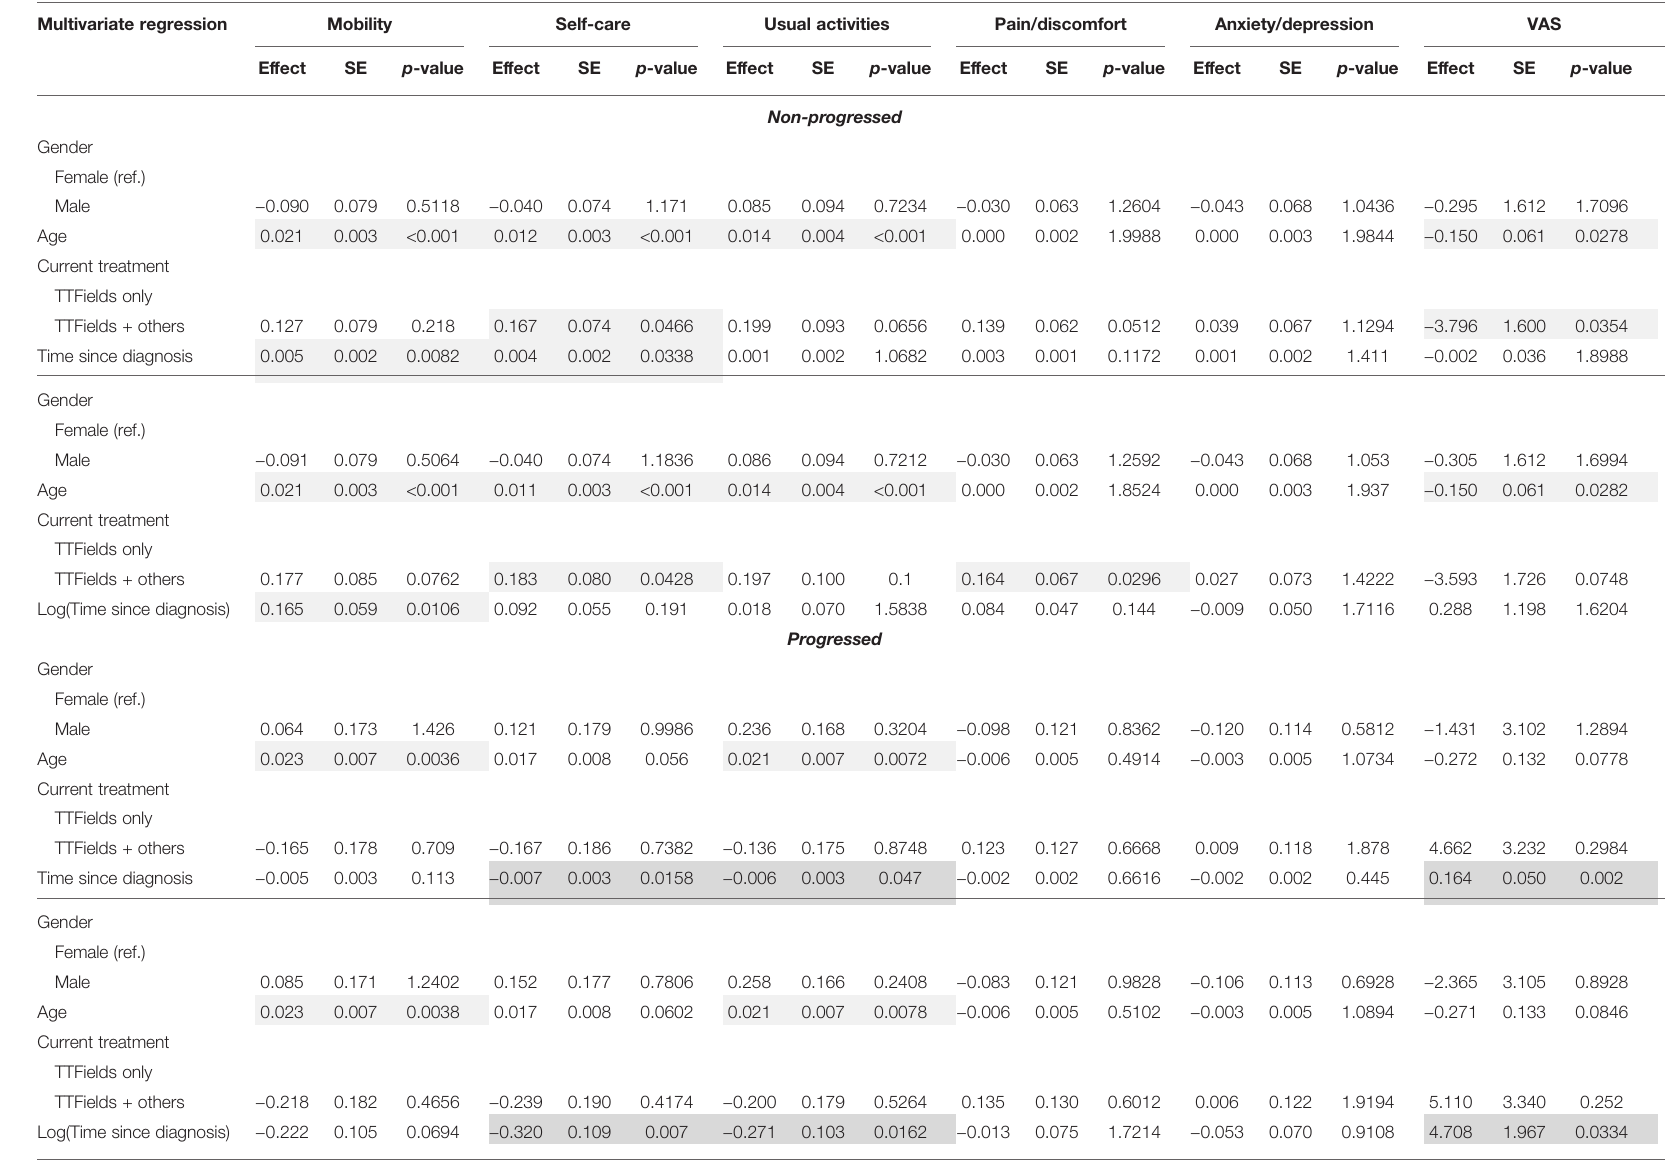
TABLE 7 | Multivariate regression results for the non-progressed and progressed subgroups with time since diagnosis. Multivariate